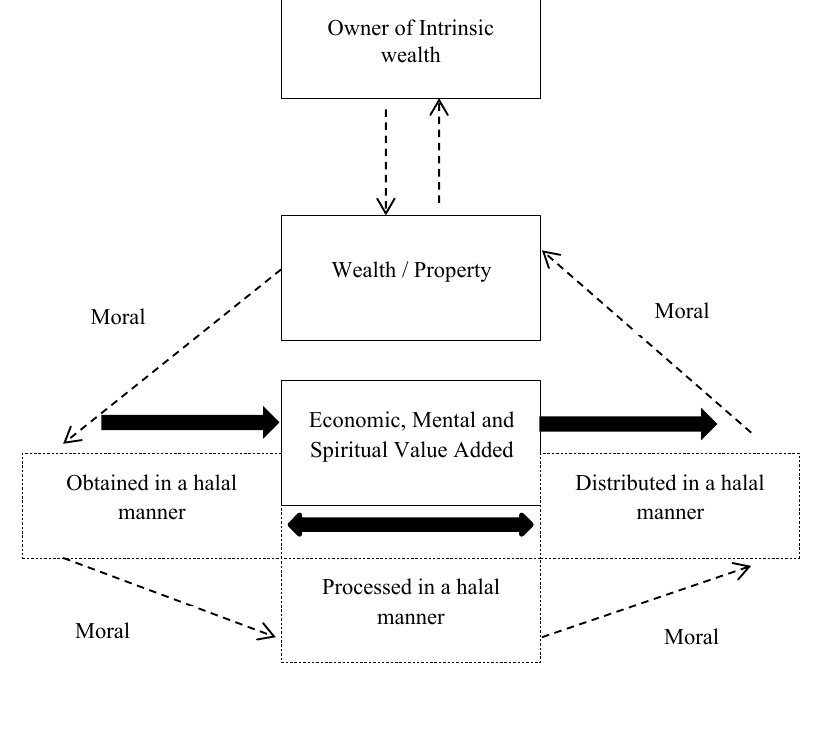
Figure 1: Kaamilah Sharia Value Added with the Qur'anic